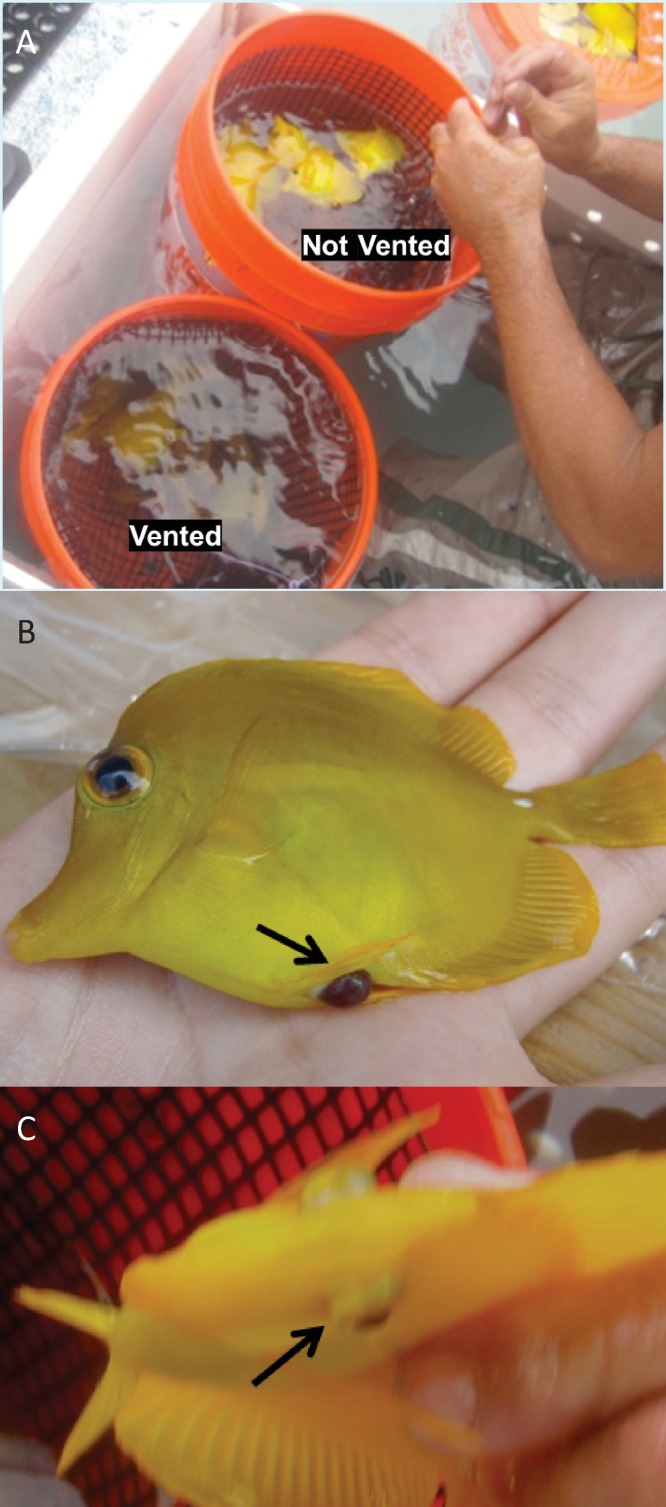
Barotrauma signs observed in Yellow Tang following collection.(A) Positive buoyancy before venting and neutral to negative buoyancy following venting (B) intestinal protrusion from the cloaca and (C) exophthalmia.